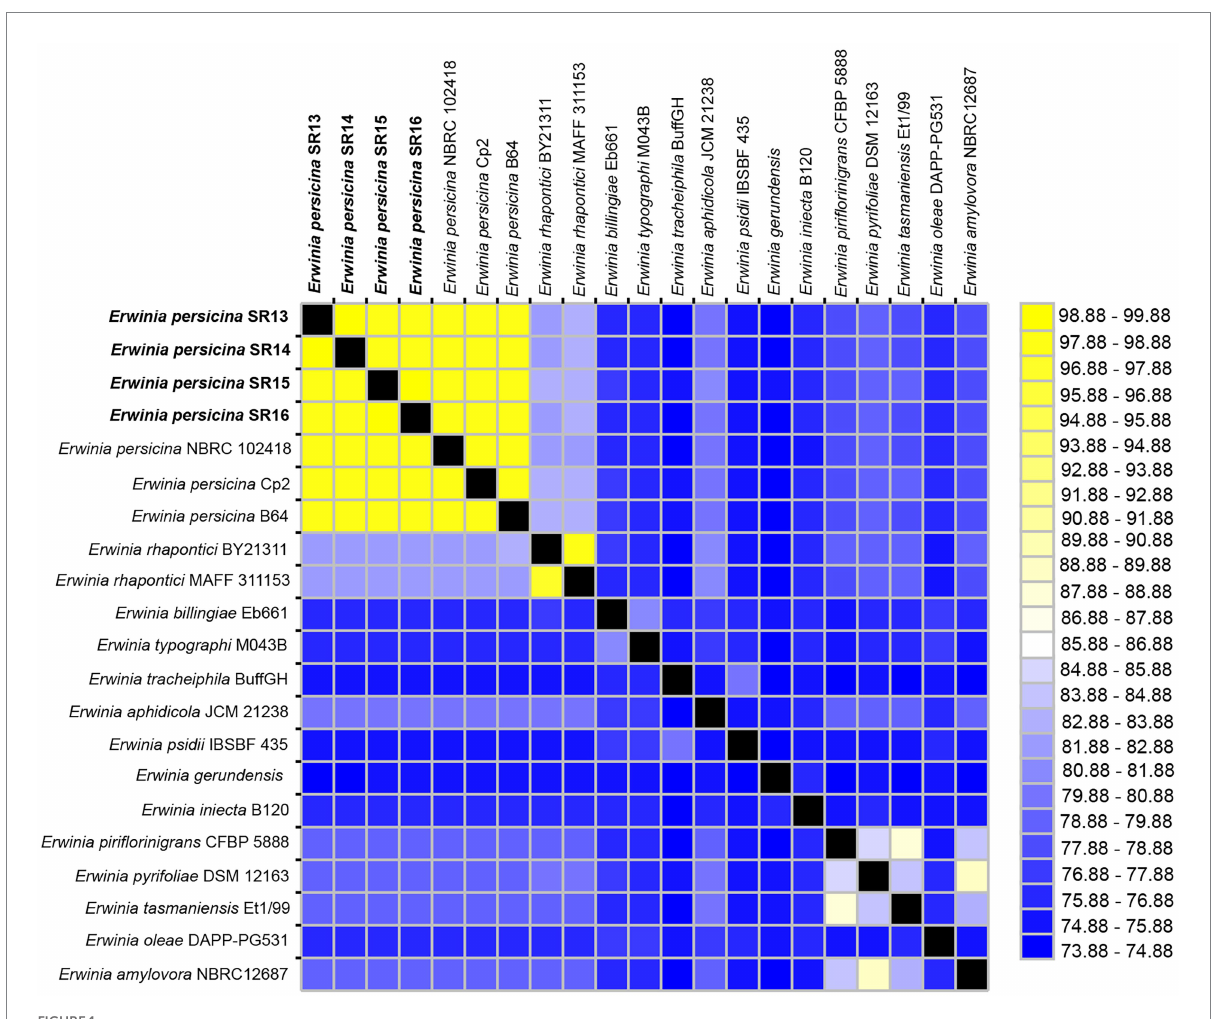
TABLE 3 Erwinia persicina soft rot isolate genome